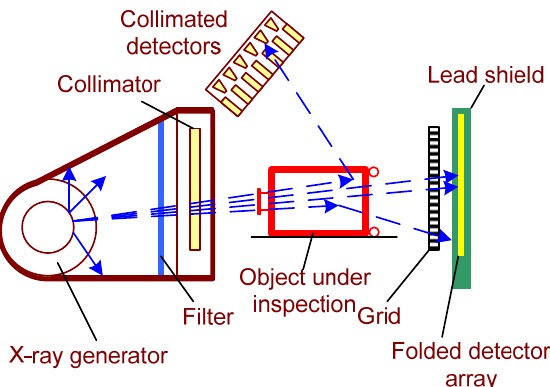
Figure 6. Schematic of a backscattering geometry situation.